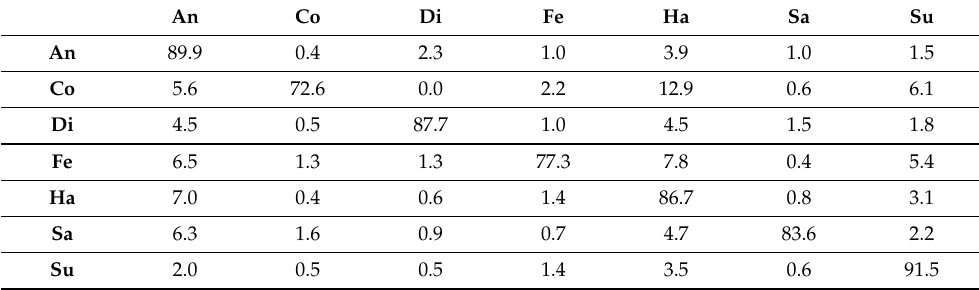
Table 3. Confusion matrix: Modified CNN-based facial motion flow (CK+).